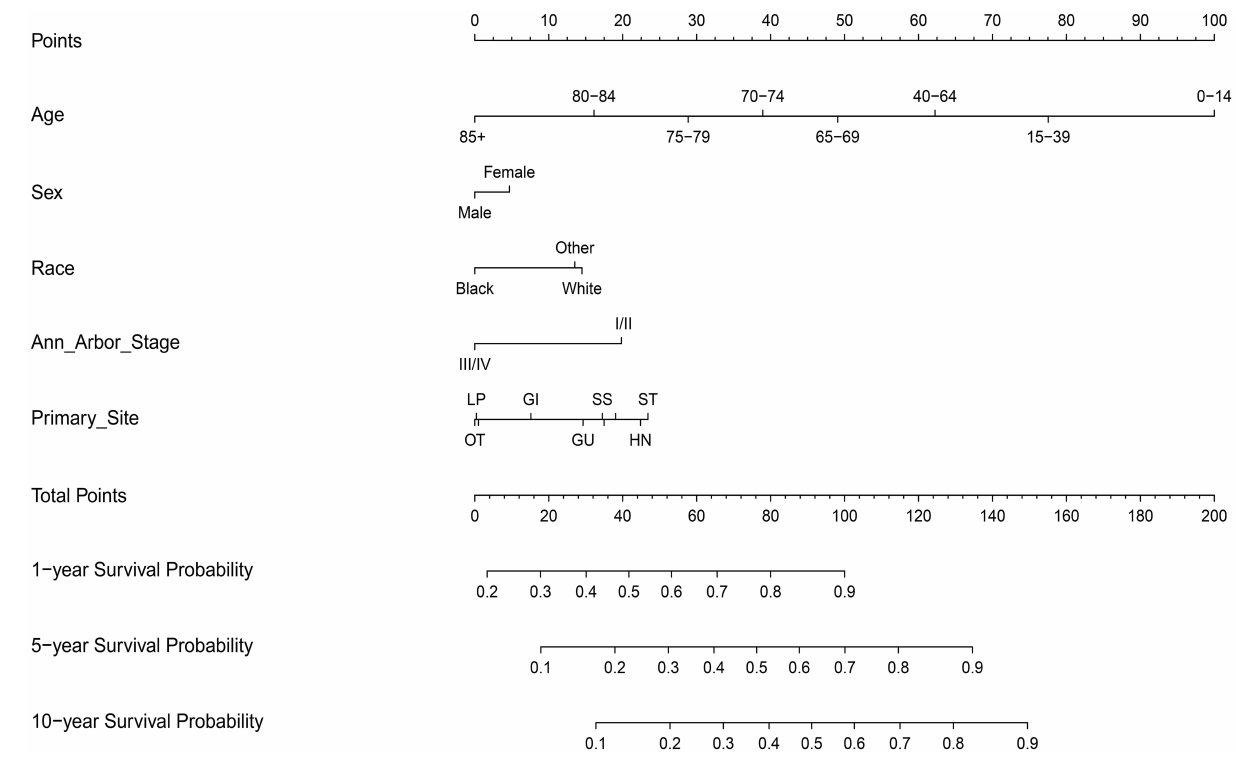
(14). For example, the elderly were more likely to have higher levels of BCL2 than younger patients